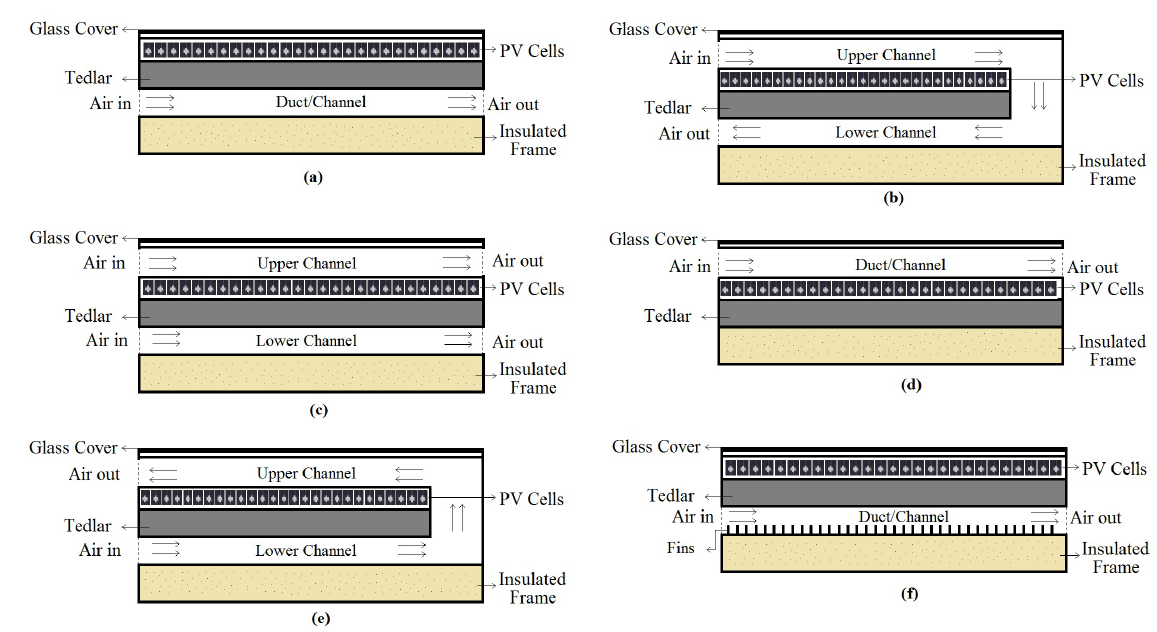
Figure 5. Different configurations of air-based PV/T